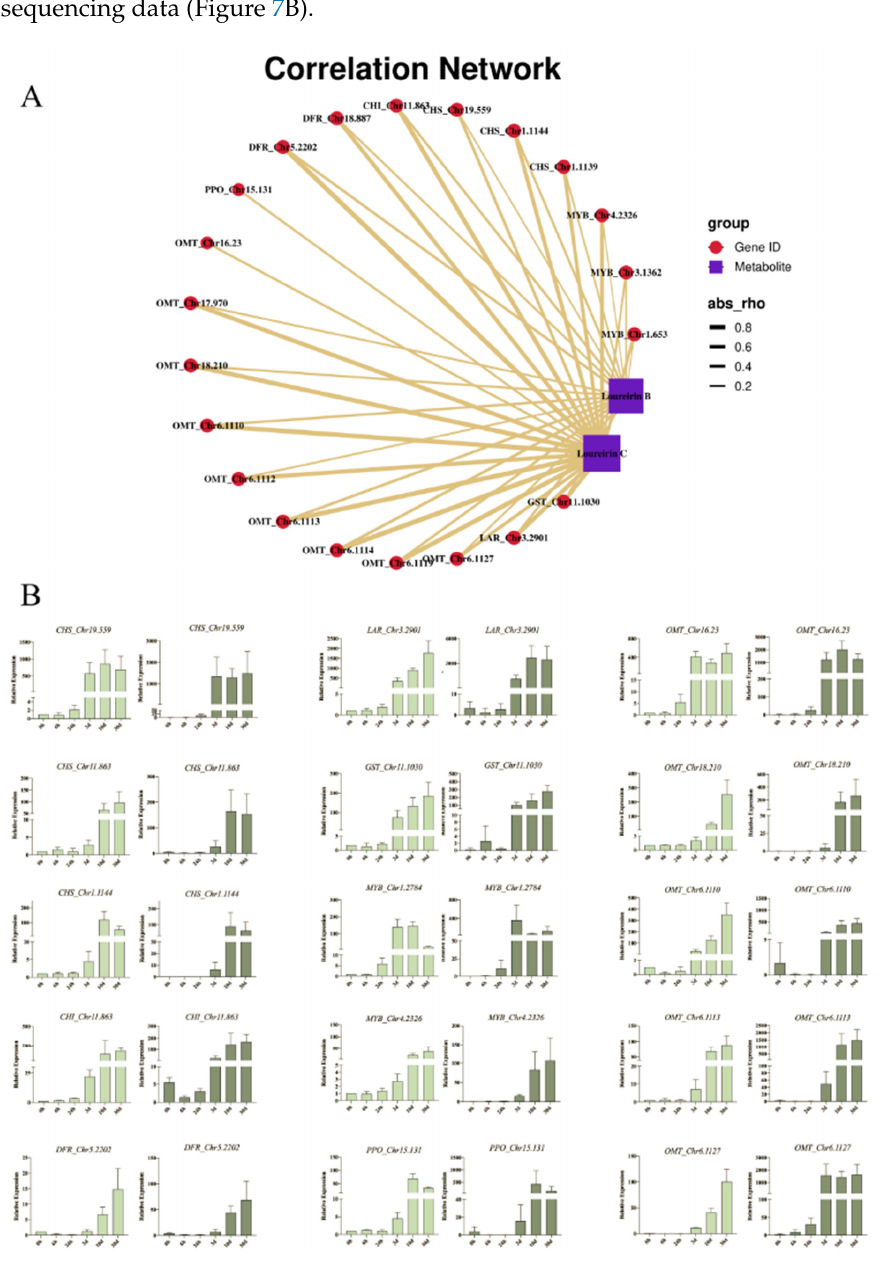
Figure 7. Putative genes related to the biosynthesis of loureirin B and C and their qRT-PCR validation: ( A ) network of putative genes and compounds; ( B ) qRT-PCR results of putative genes.